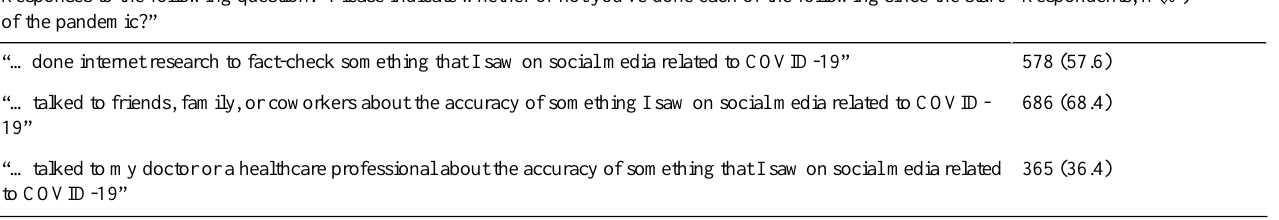
Table 3. Fact-checking pandemic-related information on social media. a